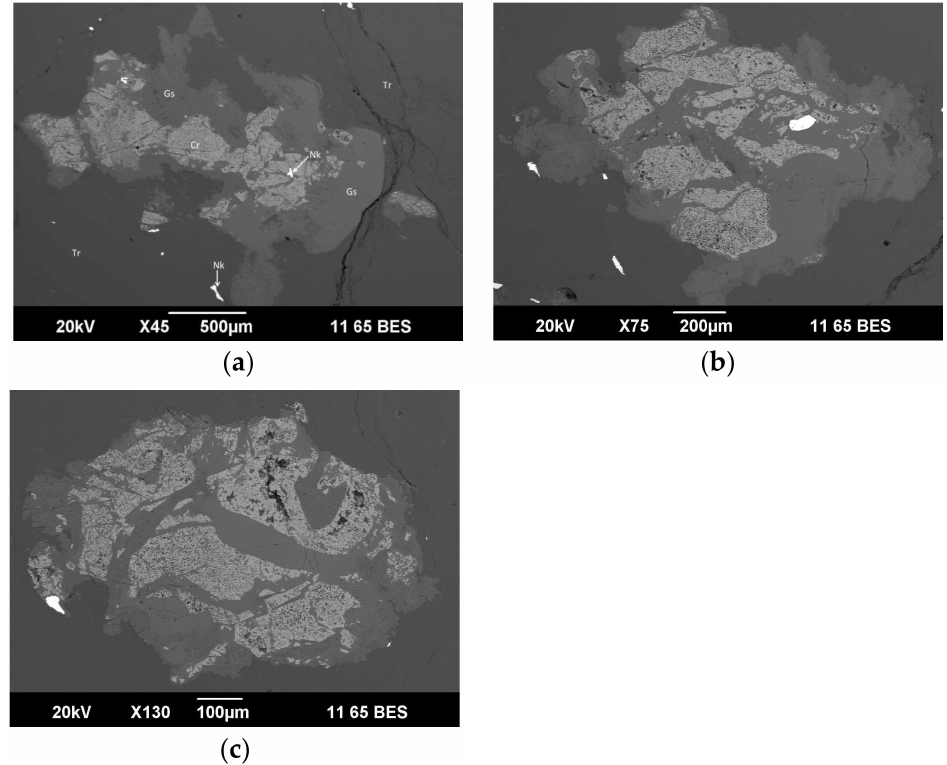
Figure 5. Resorbed chromite (Cr) grain is corroded and overgrown with a rim of chrome grossular (Gs). Nickeline (Nk) in both chromite and tremolite (Tr). ( a ) × 45; ( b ) × 75; ( c ) × 130. The nephrite and the transitional tremolite rocks are characterized by thin, less than 1 mm, grains of nickeline and maucherite of light yellow color with a metallic luster. Single grains of nickeline with an admixture of antimony up to 7.24 wt. % (Table 3), 0.05–0.12 mm in size were found, both in tremolite and in cracks in chromite grains (Figure 5). Nickeline from transitional tremolite rock contains more Co (Table